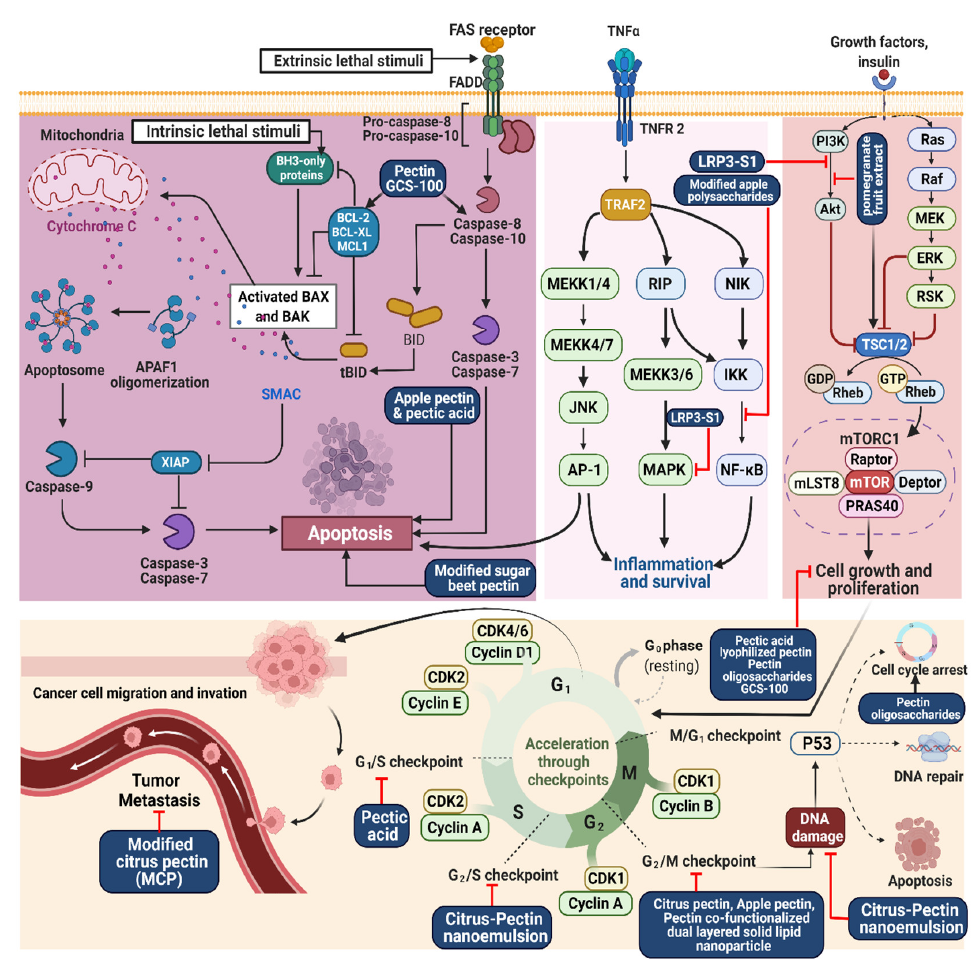
Figure 2. Illustration representing the site of action of pectin and associated pectins in cancer treat- ment.